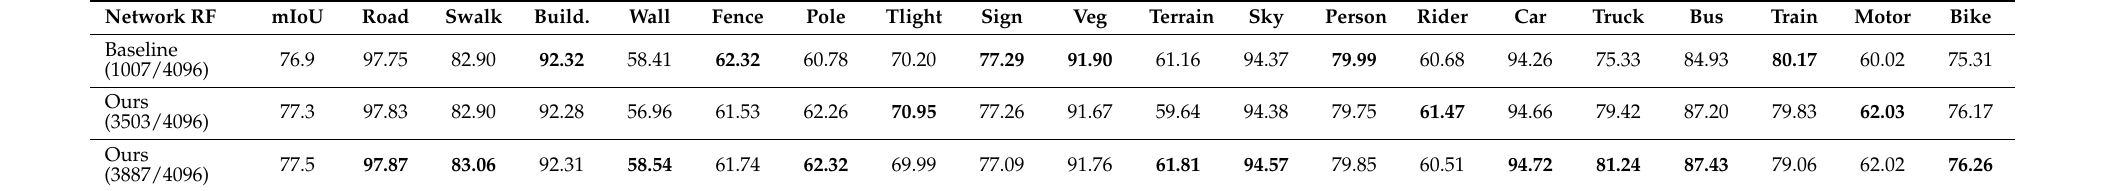
Table 1. Three different receptive field networks’ per-class mIoU results on the Cityscapes val set. Network